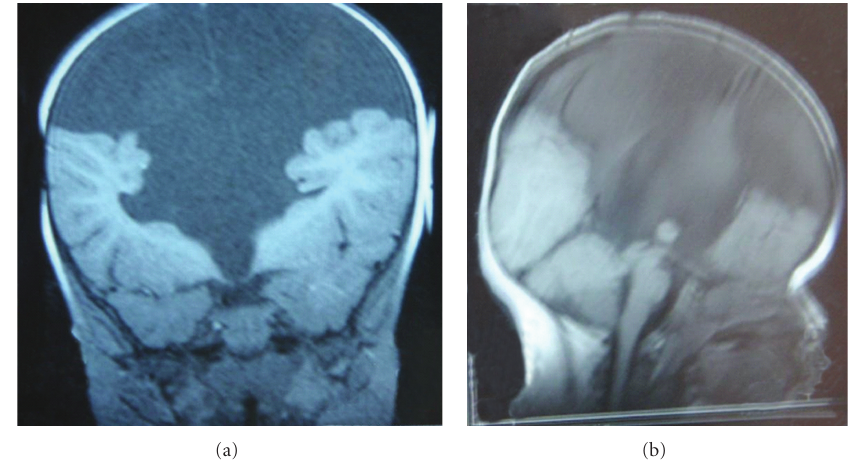
Figure 2: Magnetic resonance imaging of the brain revealing lobar